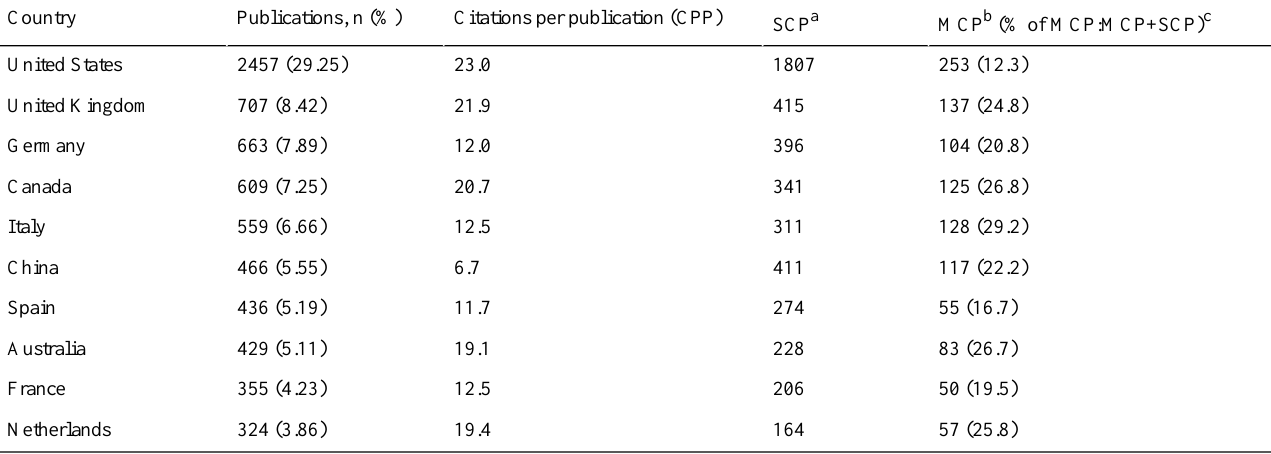
Table 3. The 10 most productive countries of virtual reality research in medicine (8399